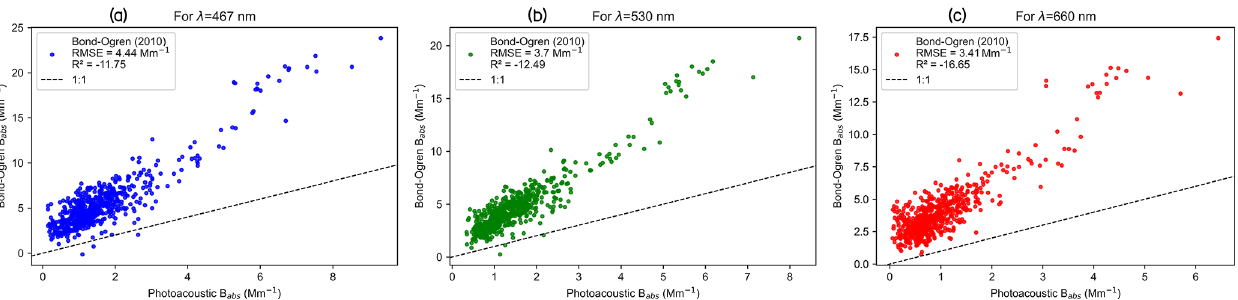
Figure 4. Comparison between PSAP absorption coefficients, corrected for using the Bond–Ogren correction algorithm, and the reference PASS absorption coefficients measured at the SGP site corresponding to the (a) 467nm, (b) 530nm, and (c) 660nm